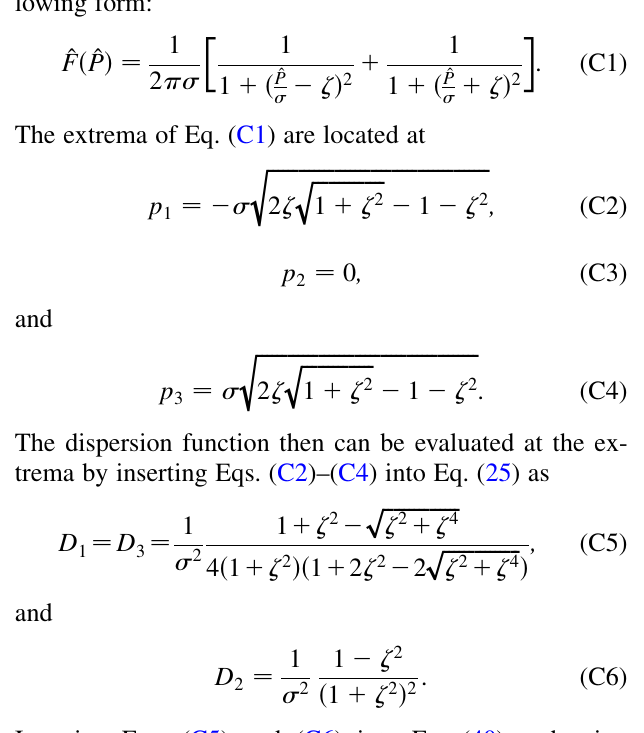
shows the roots found by direct numerical solution, which fully agree with the calculations from Eq.